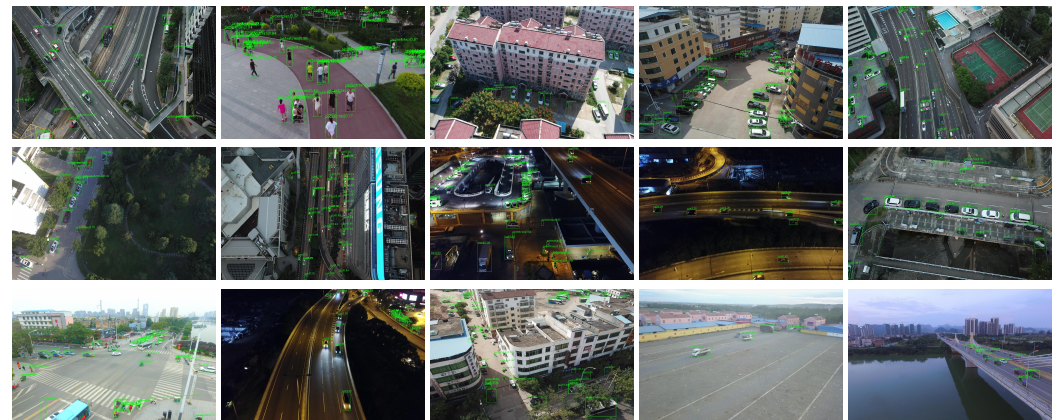
Figure 3. Detection results of the proposed GDF-Net approach on the VisDrone dataset. Detections are labeled in green rectangles and marked with associated categories and confidence scores.